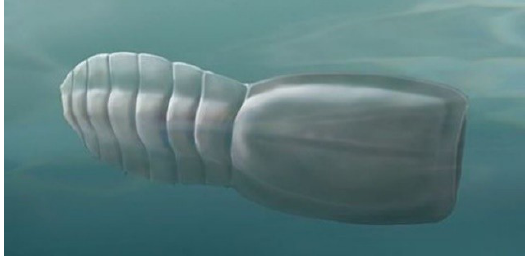
Figure 9. Nesonektris aldridgei . Image credit: Modified from D. García-Bellido. Used here per CC BY- SA 4.0.